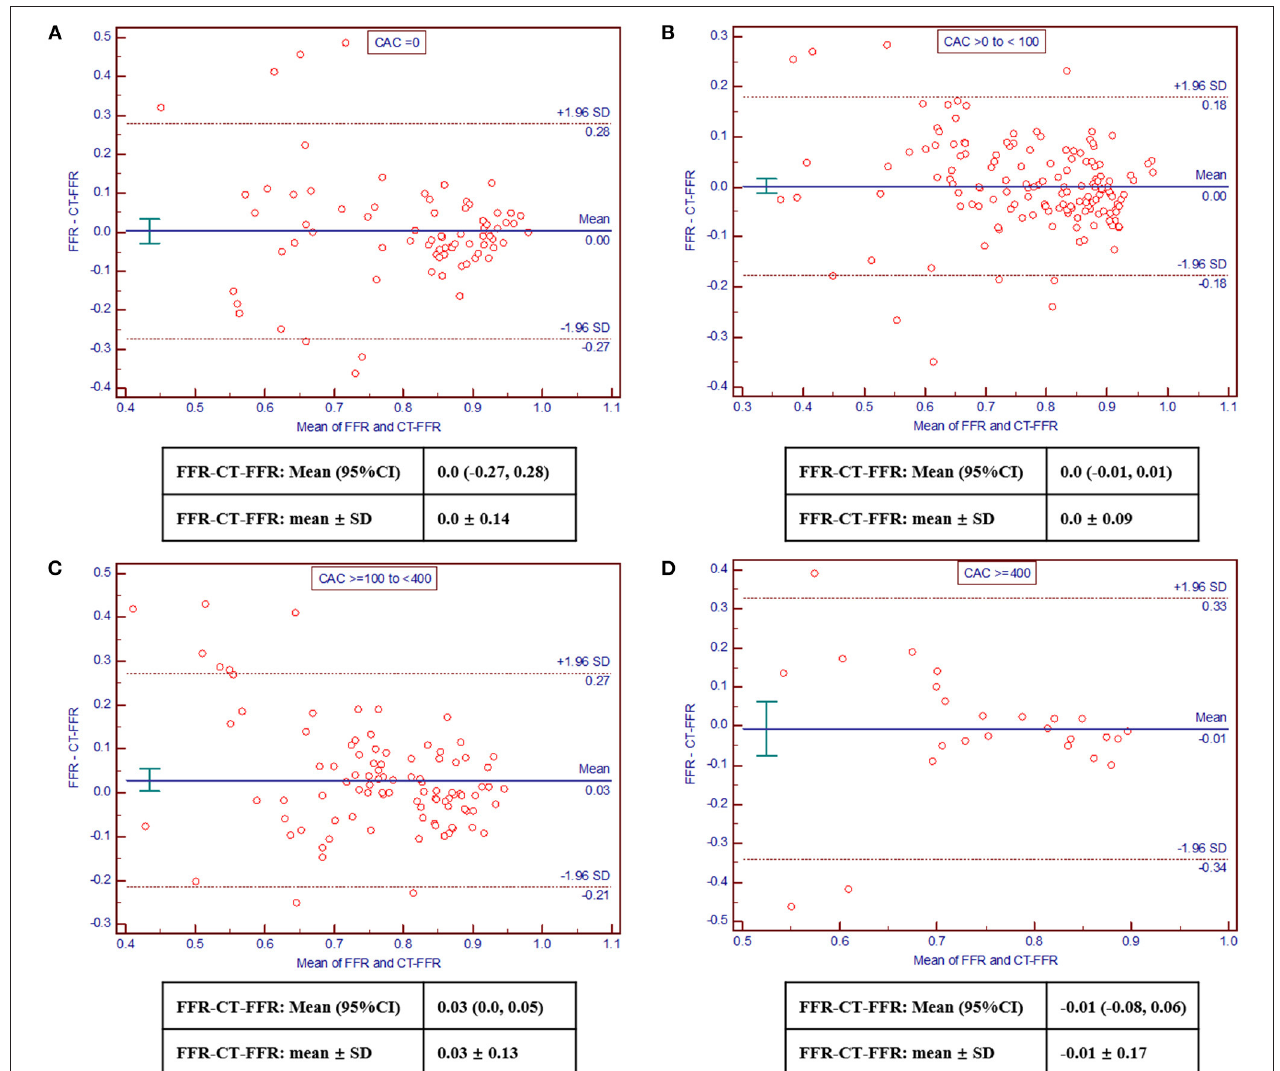
FIGURE 3 | Bland-Altman plots comparing CT-FFR with invasive FFR. Good and acceptable consistency of CT-FFR and invasive FFR across CAC score categories was observed [ (A) , CAC = 0; (B) , CAC > 0– < 100; (C) , CAC ≥ 100– < 400; (D) , CAC ≥ 400]. CAC, coronary artery calcium; CT-FFR, computed tomography derived fractional flow reserve; FFR, fractional flow